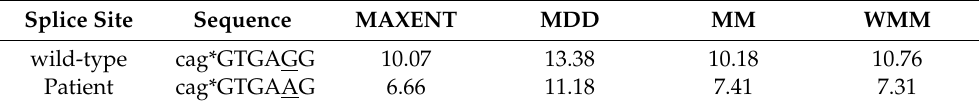
Table 2. 5 (cid:48) splice site prediction model for the MLIV c.237+5 G>A mutation. Splice